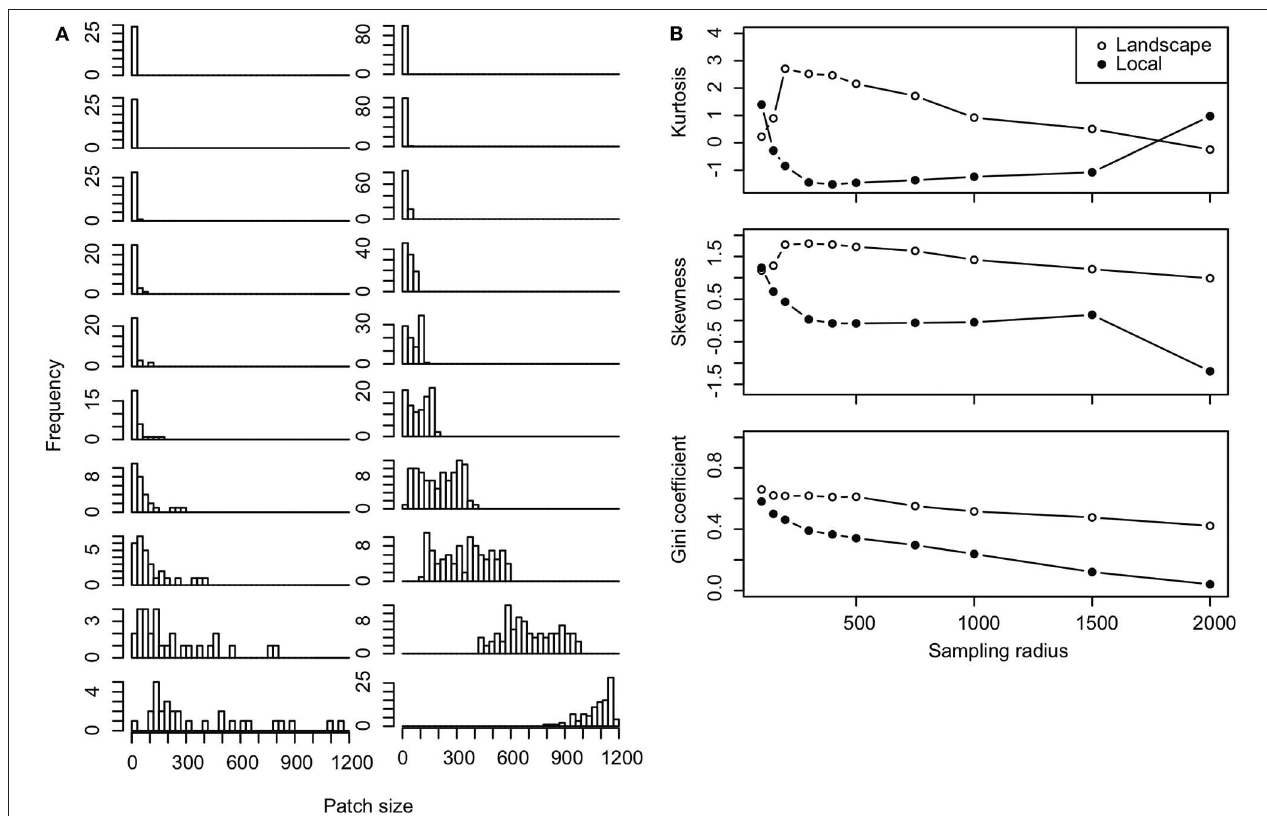
FIGURE 4 | Shifting patch size distributions. (A) Histograms of patch size at each sampling radius of 100, 150, 200, 300, 400, 500, 750, 1,000, 1,500, 2,000m (from top to bottom rows) are plotted for local (left column) and landscape-plot samples (right column). (B) Kurtosis, skewness and Gini coefficients calculated for patch size distributions at each sampling radius in landscape (open circles) and local-plot samples (solid